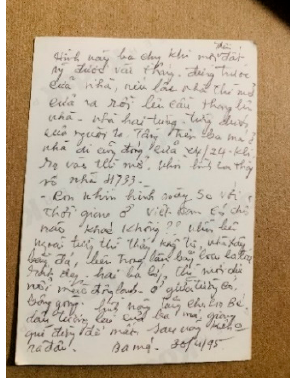
Figure 5. A letter was written by my grandpa when he first came to the U.S.